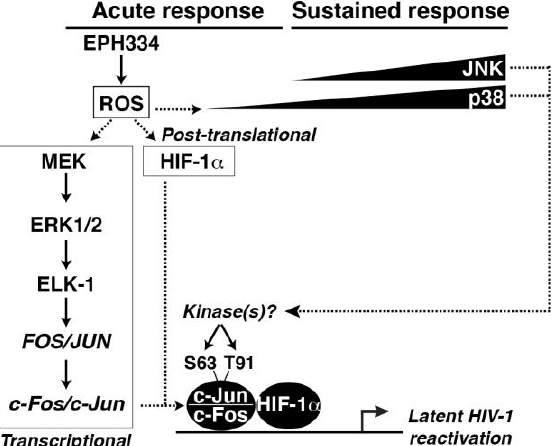
Figure 8. Simplified model of host cell redox alterations influencing HIV-1 proviral transcription and reactivation from latency. First, EPH334 induces an “acute response” by eliciting ROS-dependent induction of the MEK-ERK1/2 axis and p38. The MEK-ERK1/2 axis, probably through ELK-1, transcriptionally induces FOS and JUN to form the AP-1 dimeric TF complex. ROS-mediated hypoxia simultaneously induces HIF-1 α through a non-transcriptional mechanism. Second, EPH334 induces a sustained response through which the levels of the induced TFs and site-specific phosphorylation of c-Jun (S63 and T91) is maintained. Consequently, AP-1 and HIF-1 α cooperate to activate latent HIV-1.